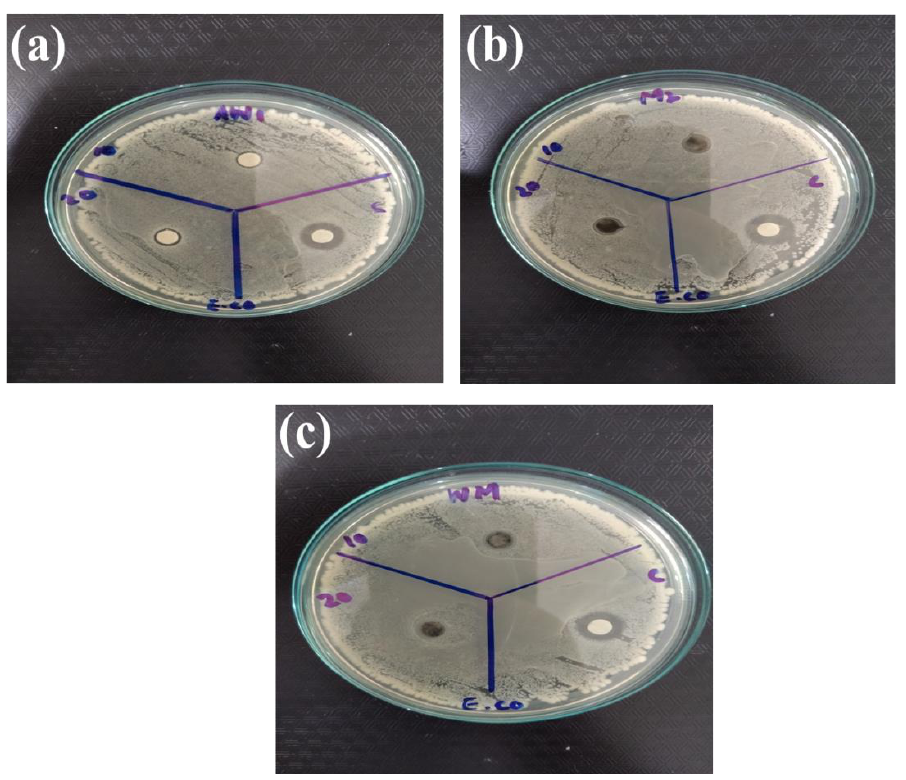
Figure 14. Antibacterial activity of as-prepared samples ( a ) WO 3 , ( b ) Mxene and ( c ) WO 3 /Mxene against Escherichia coli (E. coli ).